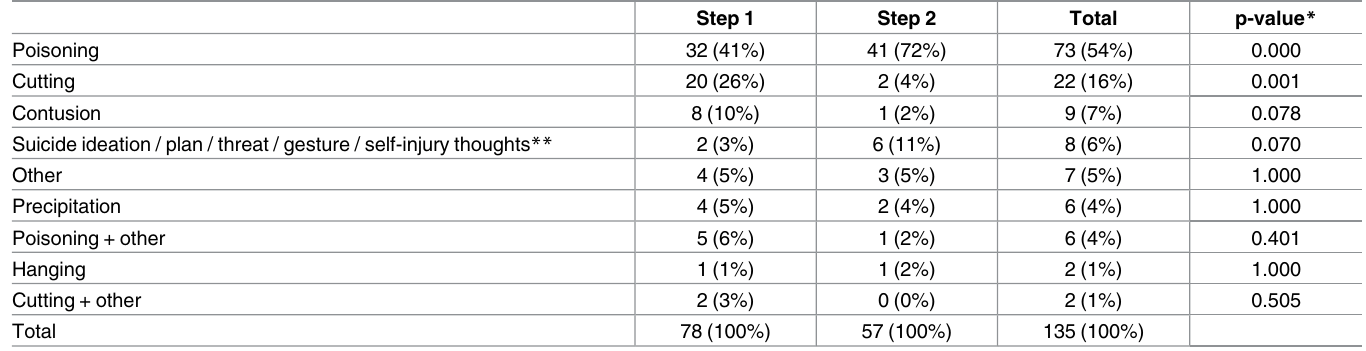
Table 3. SITB cases visited in the EDs (n = 135): frequency and percentage of different methods used, including thoughts.